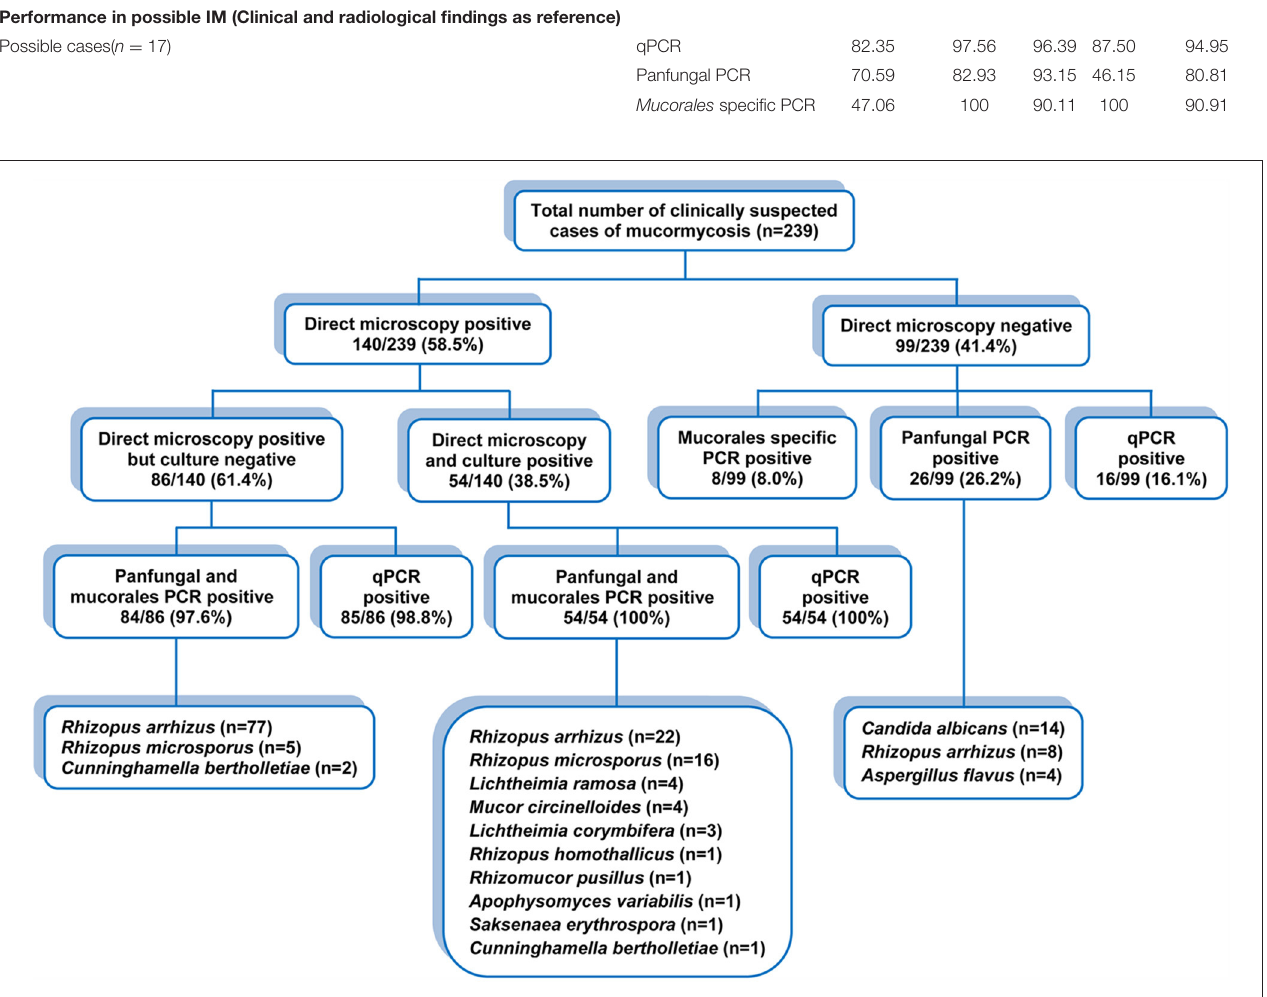
FIGURE 5 | Detailed description of the results of conventional and molecular techniques (IM